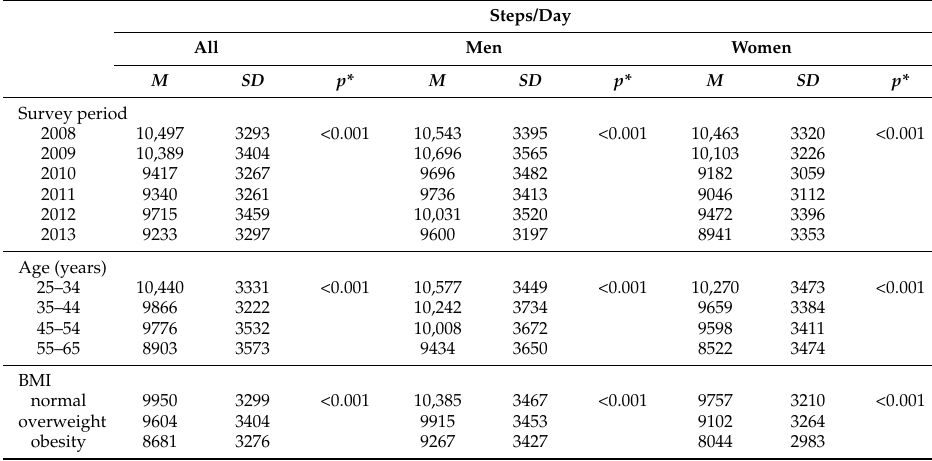
Table 2. Steps/day values in relation to survey periods, age, and body mass index (BMI) in men, women, and all participants. Steps/Day All